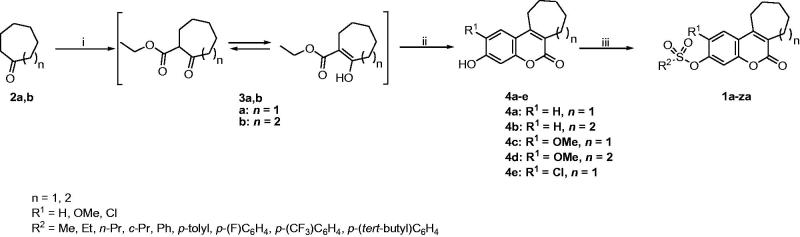
Reagents and conditions: (i) diethyl carbonate, NaH, benzene, reflux, 90% (3a, n = 1), 85% (3 b, n = 2); (ii) (substituted) resorcinol, CF3COOH, conc. H2SO4, 0 °C; rt, 3 h; (iii) appropriate sulphonyl chloride derivative, triethylamine, CH2Cl2, 0 °C; rt, 1 h.